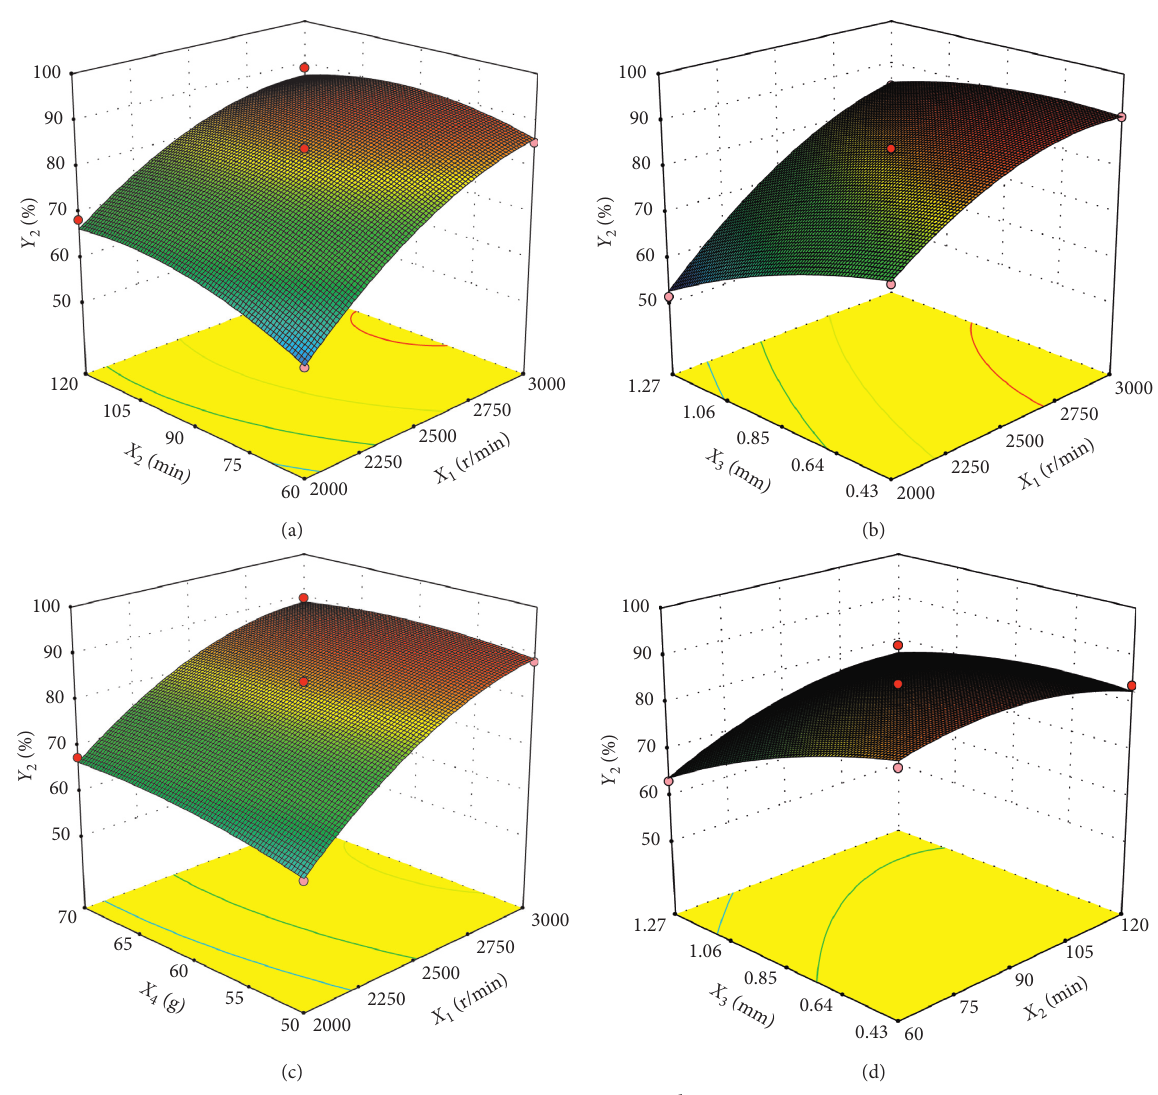
Figure 10: Effect of interaction factors on the change rate of the cross-linking signal intensity. (a) X X 4 � 60g. (c) X 2 � 90min, X 3 � 0.85mm. (d) X 1 � 2500r/min, X 4 � 60g. (e) X 1 � 2500r/min, X 3 � 0.85mm. (f) X 1 � 2500r/min, X 2 �